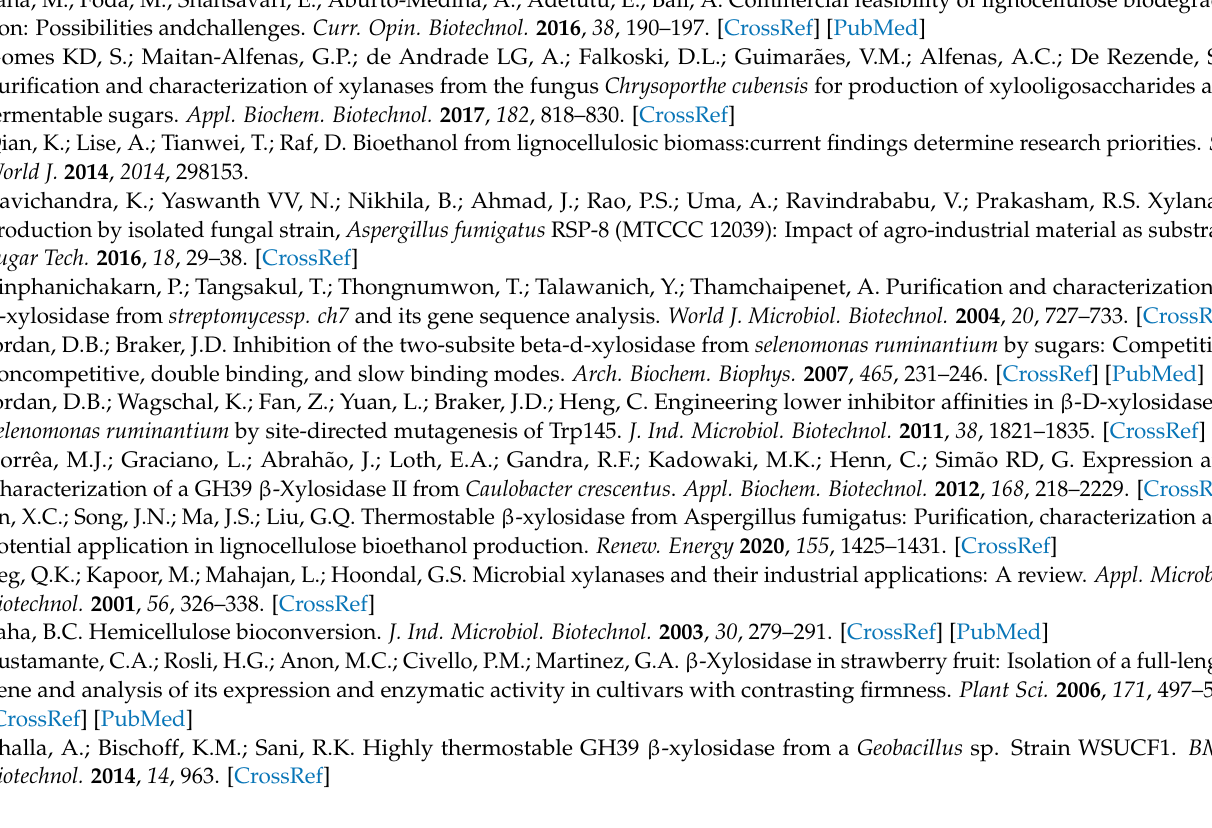
Figure S2: Amino acid sequence of PpBXL. The six identified peptides are marked with